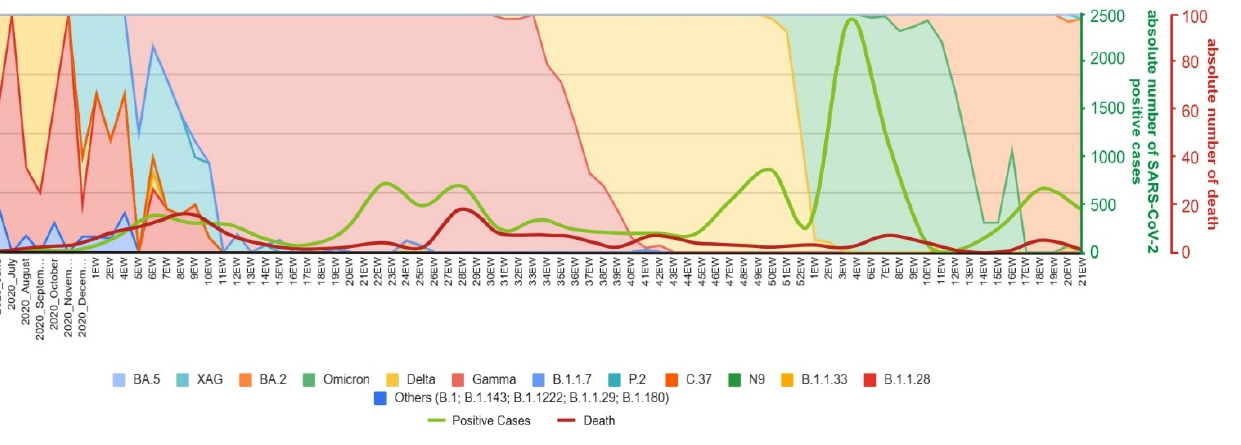
Figure 5. The SARS-CoV-2 epidemic in Serrana. Substitution dynamics of SARS-CoV-2 lineages by wave and epidemiological week (EW), Y-axis, frequency (%) of SARS-CoV-2 lineages by period (X- axis). Absolute number of SARS-CoV-2 positive cases ranging from 0–2500 (green line) and mortality ranging 0–20 (red line) during this period.